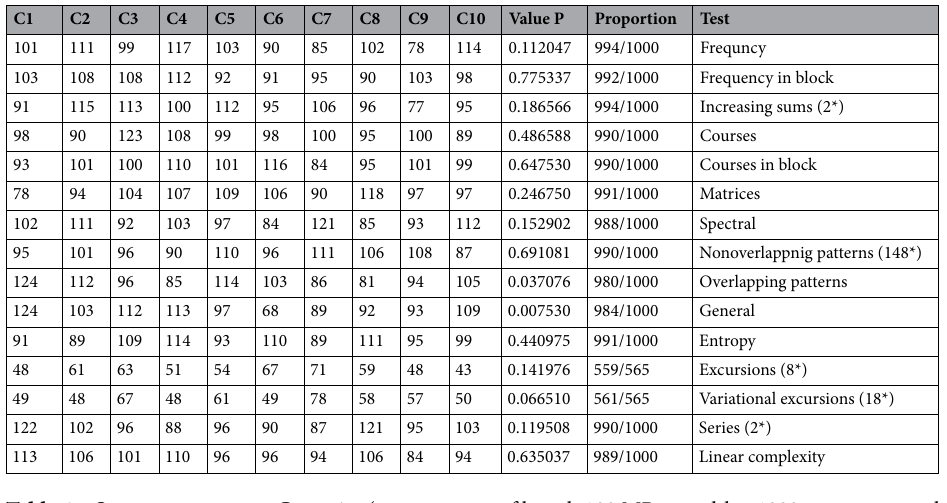
Table 4. Quantum generator Comscire (test sequence of length 100 MB, tested k = 1000 sequences, each consistent of n = 800 000 bits), by * (number of performed sub-tests) indicated averaged proportions and values of p for uniformity distribution test for results related to particular sequences.